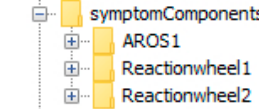
Figure 29. The symptom components AROS1, Reactionhweel1, and Reactionhweel2 corresponding to the detected discrepancies listed in the diagnosis.xml-file.